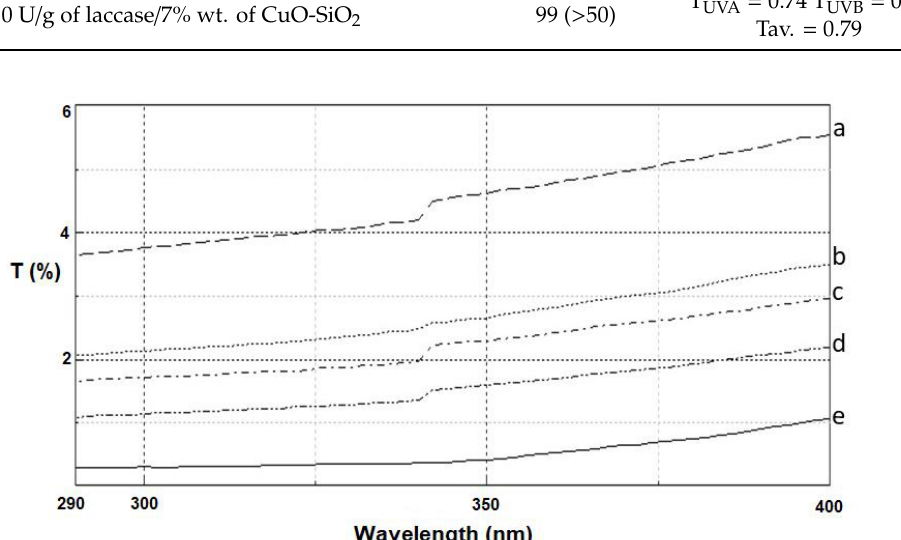
Figure 3. Transmittance spectra (%T) in the range λ = 290–400 nm for: a. raw linen, b. linen woven fabric after dip-coating with 7% wt. of CuO-SiO 2 , c. linen woven fabric after alkaline scouring and dip-coating with 7% wt. of CuO-SiO 2 , d. linen woven fabric after enzymatic treatment with 2.5 U/g of laccase and dip-coating with 7% wt. of CuO-SiO 2 , e. linen woven fabric after enzymatic treatment with 2.5 U/g of laccase and dip-coating with 5% wt. of CuO-SiO 2 .